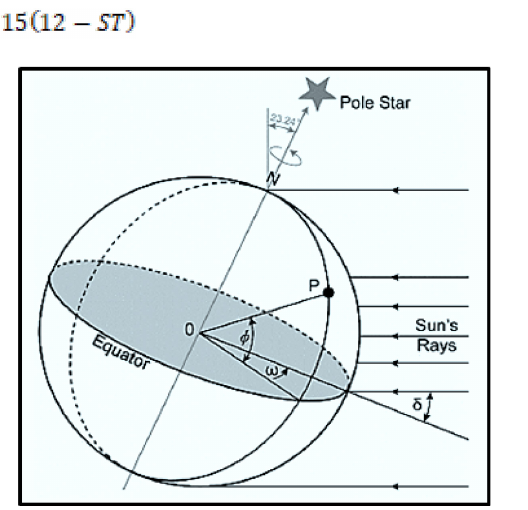
Figure 6. Hour angle [19].